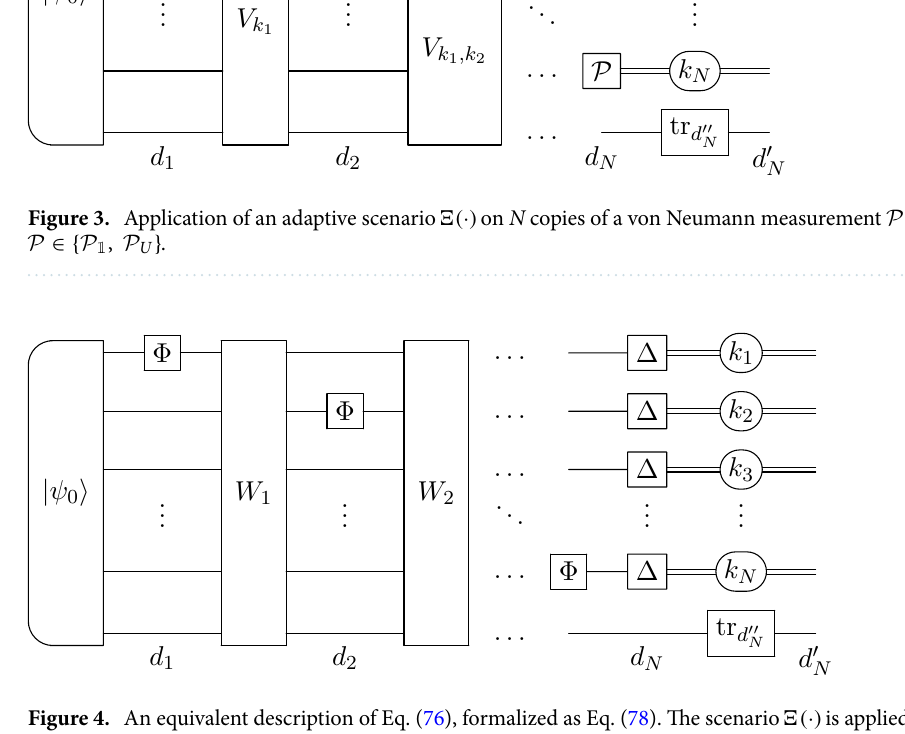
� 1 , � ( UE 0 ) † } . As a last step we perform a completely dephasing channel ∈ {